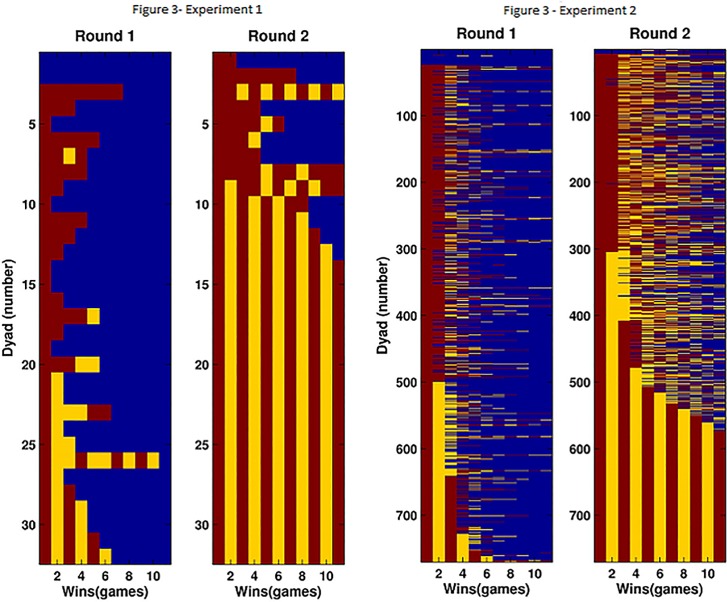
The image depicts a raster of accumulated points by each player.Each line corresponds to a dyad. Within each line columns indicate in color whether the first player (yellow) or the second player (red) won. Player 1 is defined arbitrarily as the one that scores the first point. Data are sorted by sequence proximity to an alternating strategy of cooperation (1-2-1-2-…). Perfect alternating cooperation is achieved by a very high fraction of dyads in the second round (right panels) and with extremely low frequency in the first round (first dyad).